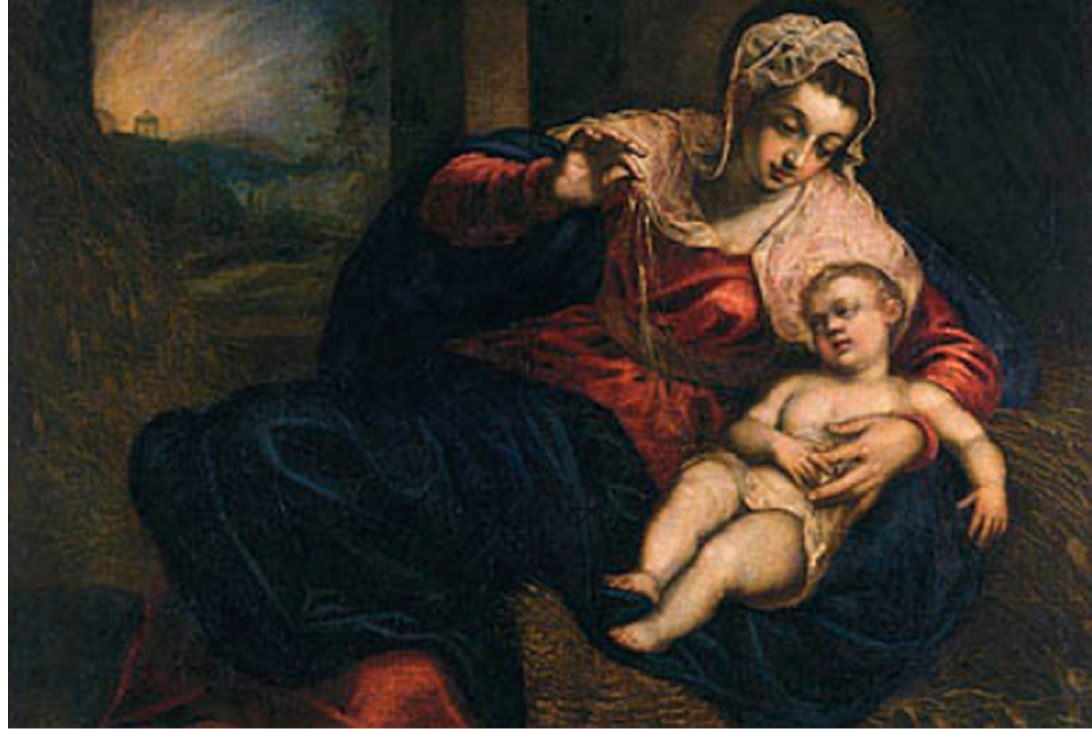
Figure 3. Tintoretto, “Madonna and Child” (c. 1570–1572), oil on canvas.